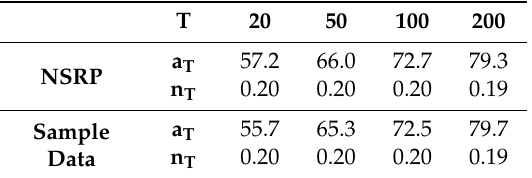
Table 4. Viterbo rain gauge: sample and NSRP estimates for a T (mm / h) and n T (-) Amount–Duration–Frequency (ADF) curves parameters. T is the return period